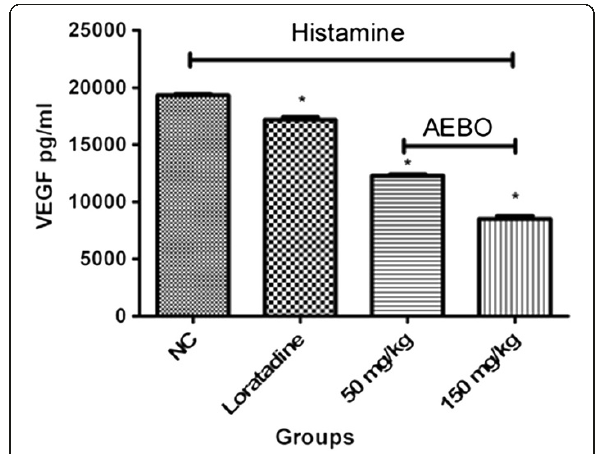
Figure 5 Influence of AEBO on histamine-induced VEGF production in rat ’ s paw. Data are presented as mean ± SEM, n = 6. * P < 0.05, significantly different from NC (negative